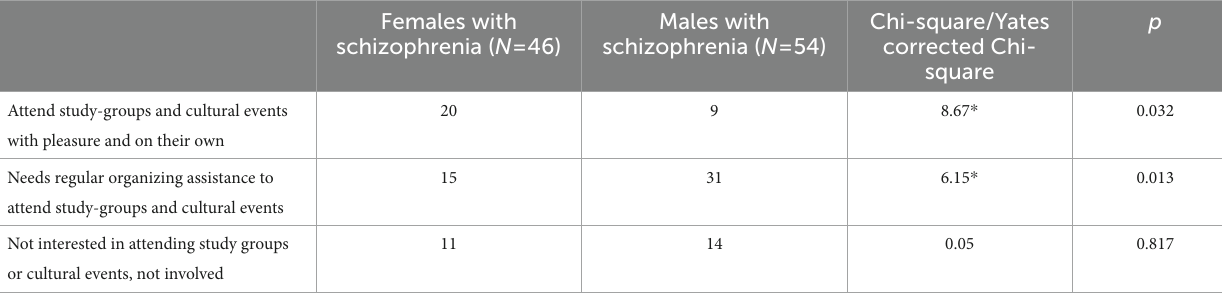
TABLE 4 Attending interest and study-groups and cultural